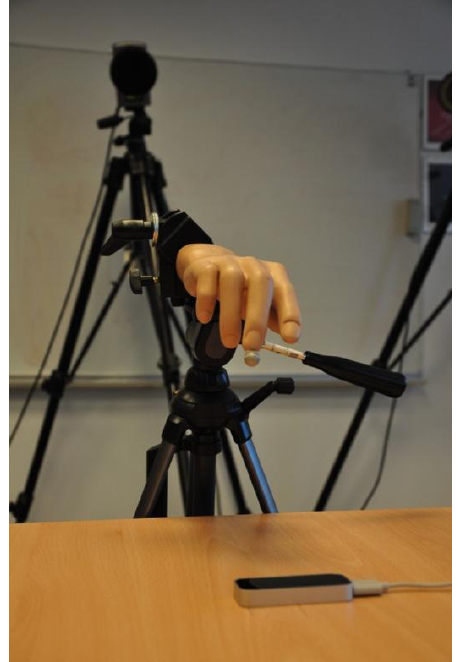
Figure 2. The setup of the experimental environment.